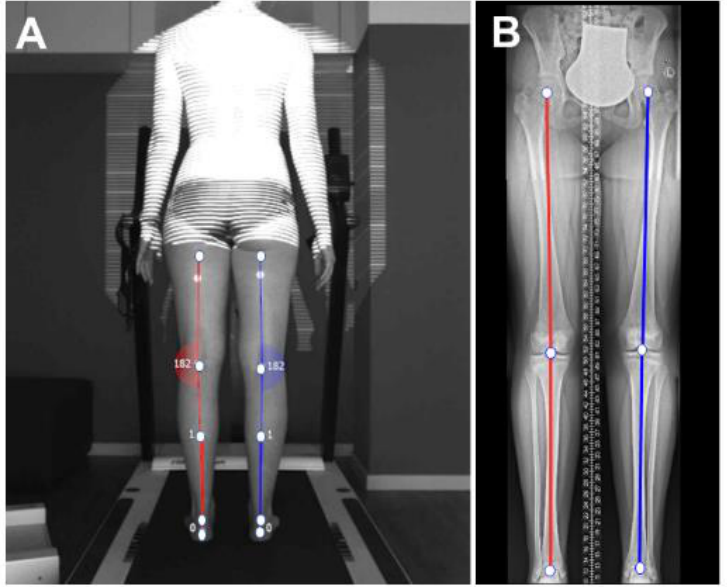
Figure 1. Representation of ( A ) Motion capture analyses (MCA): non-invasive 2D motion capture leg axis evaluation (Diers leg axis posterior ® ). Markers are placed on five anatomical landmarks of the skin (gluteal rim, middle of the popliteal fossa, middle underneath the bellies of the musculus gastrocnemius, calcaneus top edge and calcaneus lower edge) and leg axis analysis is performed; and ( B ) long-standing full-leg radiograph (LSX): mechanical axis angle (MAA rad ) is defined by the line from the hip center to the knee center and the line from the knee center to the ankle center.